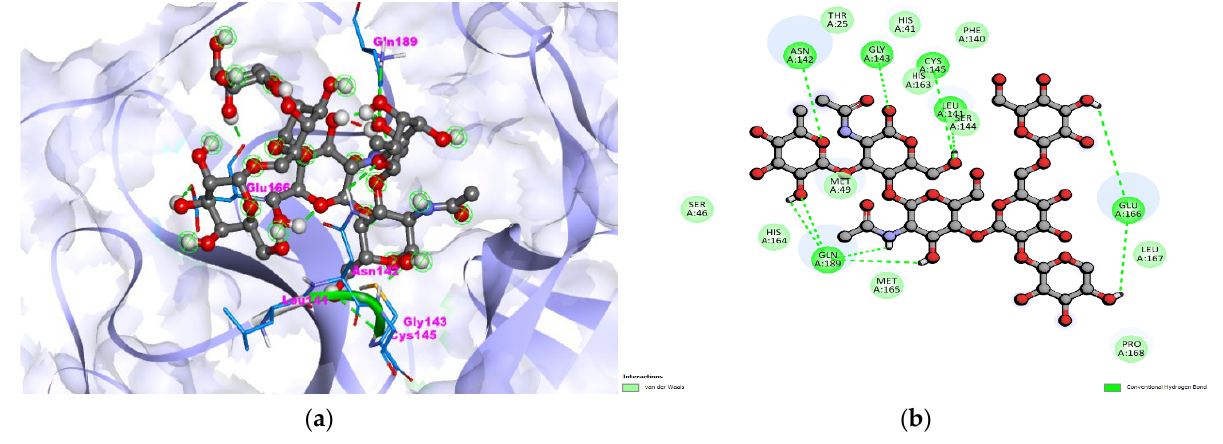
Figure 4. ( a ) Light-blue color ribbon pattern showing SARS-CoV-2 Protease (PDB: 6LU7) interaction with ( b ) bromelain is shown in grey color with ball stick pattern in the center. ( b ) 2D visualization of interaction. Table 3. Data obtained after performing Molecular interaction between bromelain/selected drug and SARS-CoV-2 protease PDB:6LU7. Where in Hydrogen bond details column UNK1 = compound.